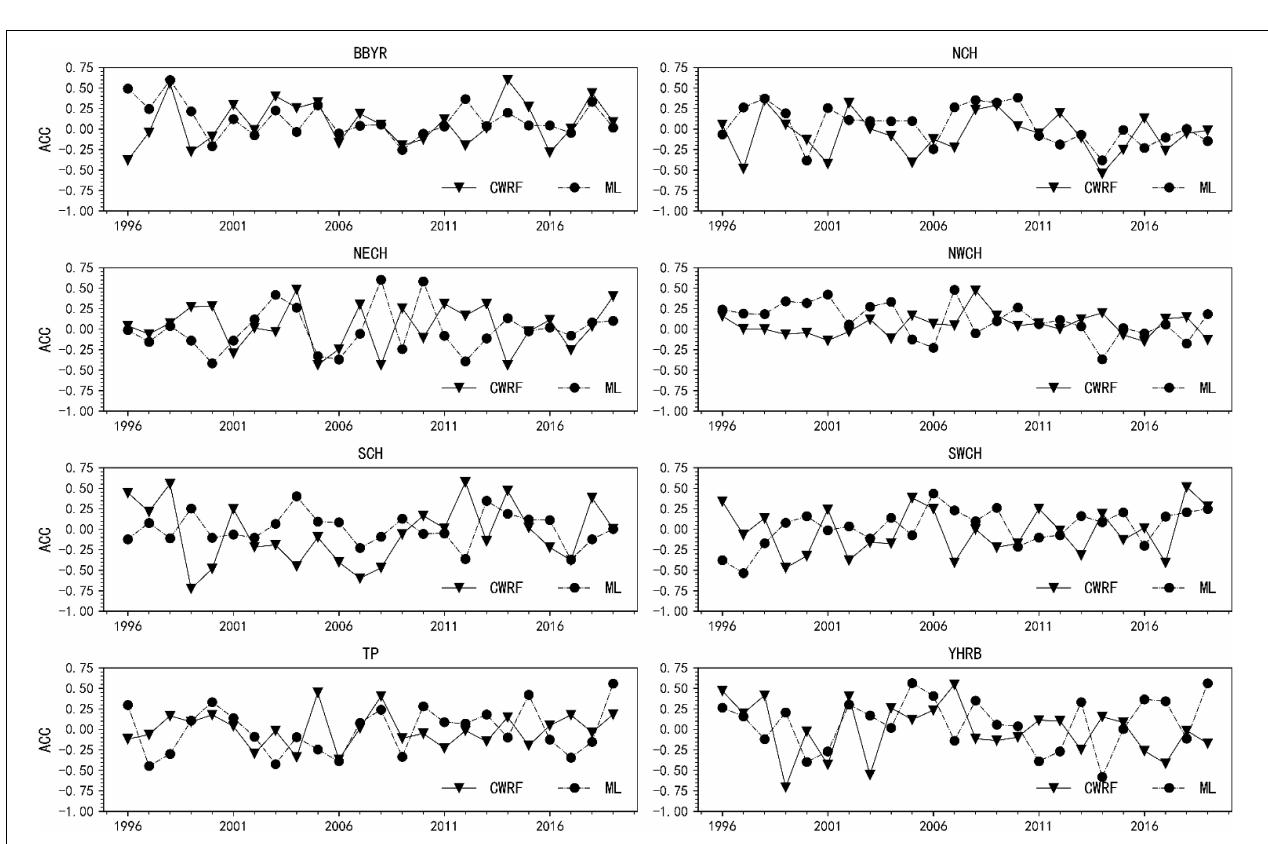
FIGURE 7 | Comparison of anomaly correlation coefficient (ACC) before and after precipitation correction in 8 sub-regions.